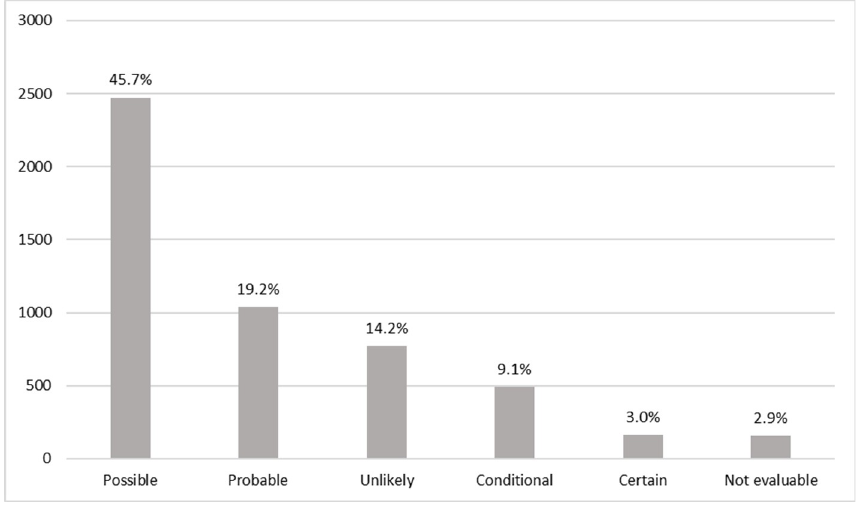
Fig 1. Adverse drug reactions by biotech agents according to probability classification to the World Health Organization in patients of Colombia.